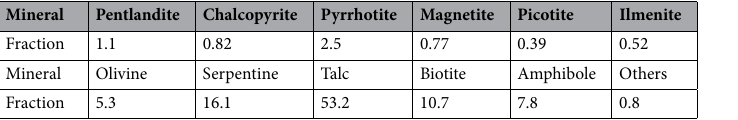
Table 3. Composition and contents of main minerals for Copper-Nickel Sulfide Ores (mass fraction, %).